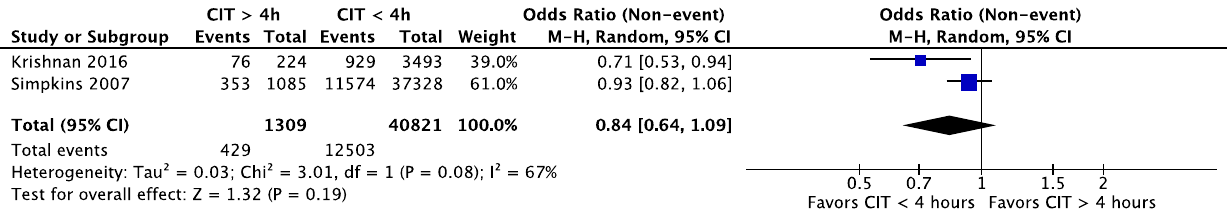
Figure 11. Ten-year graft survival for CIT shorter and longer than 4 h. CIT: cold ischaemia